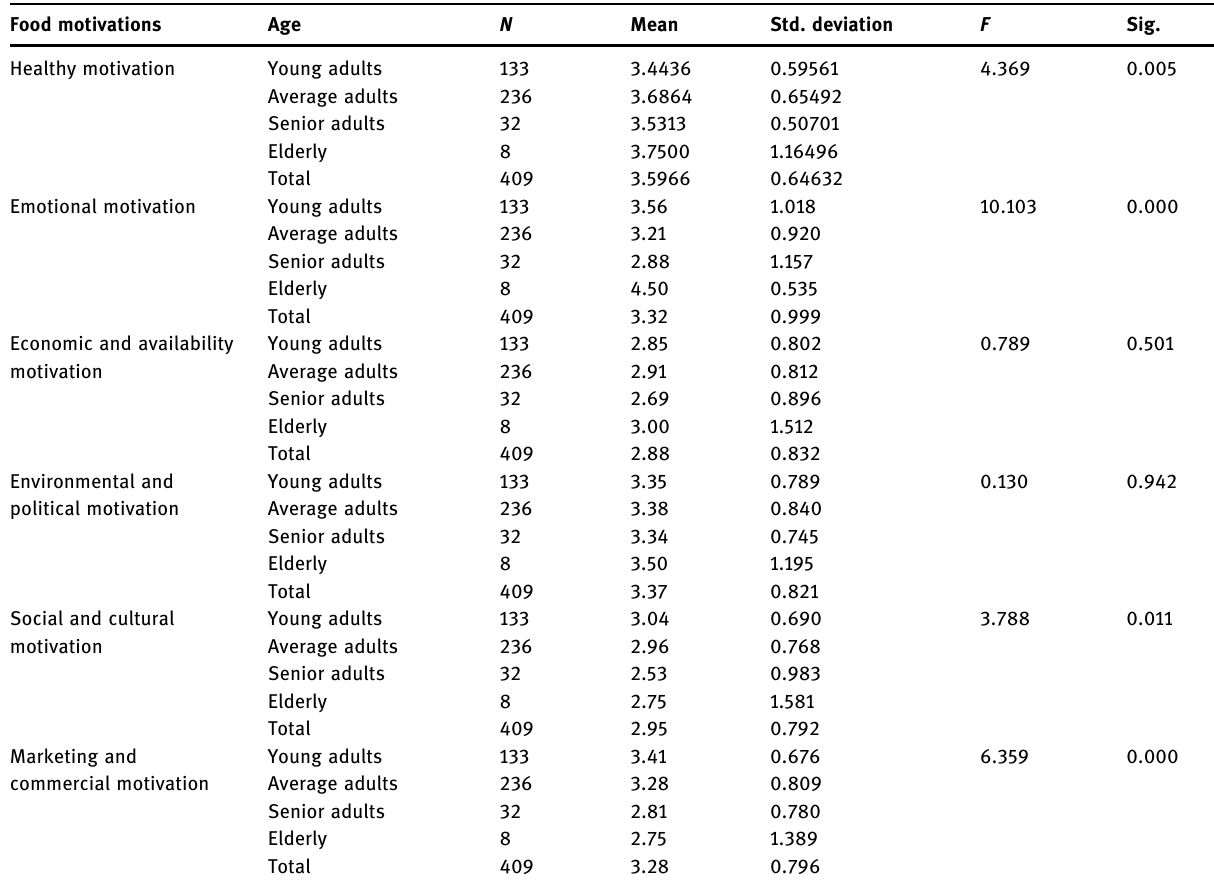
Table 3: ANOVA and mean Food motivations Healthy